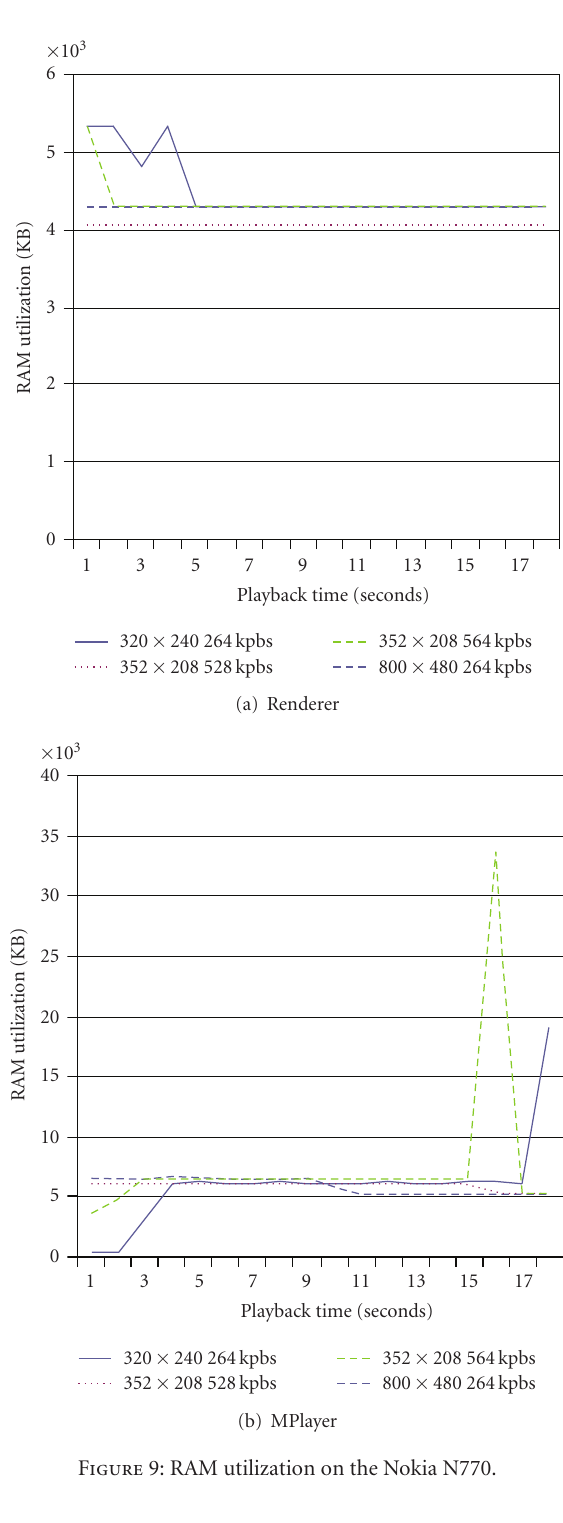
query for all available remote media items. This integration overhead is acceptable for an adaptive domestic multimedia system, where the number of media items is seldom higher than 10000 media items (causing an integration overhead of at least 92%) and the frequency of integration activities is rather